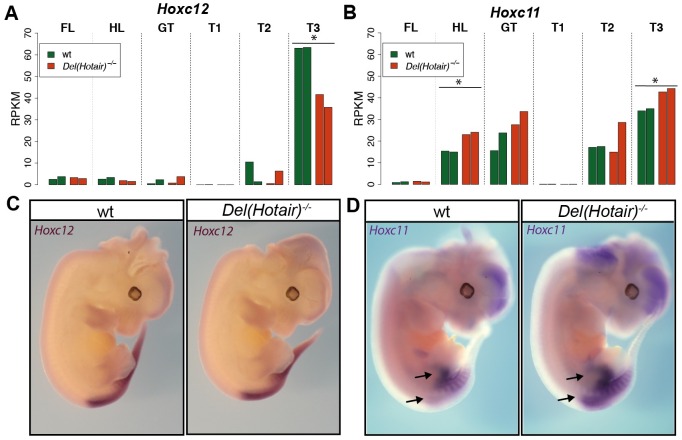
The deletion of Hotair affects the expression of the neighboring Hoxc11 and Hoxc12 genes.Hoxc12 (A) and Hoxc11 (B) expression (normalized RPKM values) in the various dissected tissue samples for wild type (green) and Del(Hotair)-/- (orange) E12.5 embryos. The asterisk* indicates those samples where significant differences in transcript levels between genotypes were scored (FDR < 10%). (C) WISH using the Hoxc12 probe in both wild type (left) and Del(Hotair)-/- (right) E12.5 embryos. The spatial expression of Hoxc12 remains globally unchanged. D) WISH of Hoxc11 in wild type (left) and Del(Hotair)-/- (right) E12.5 embryos. The arrows indicate the slight anterior shift in the expression profile and the increase in signal intensity in the mutant genotype.